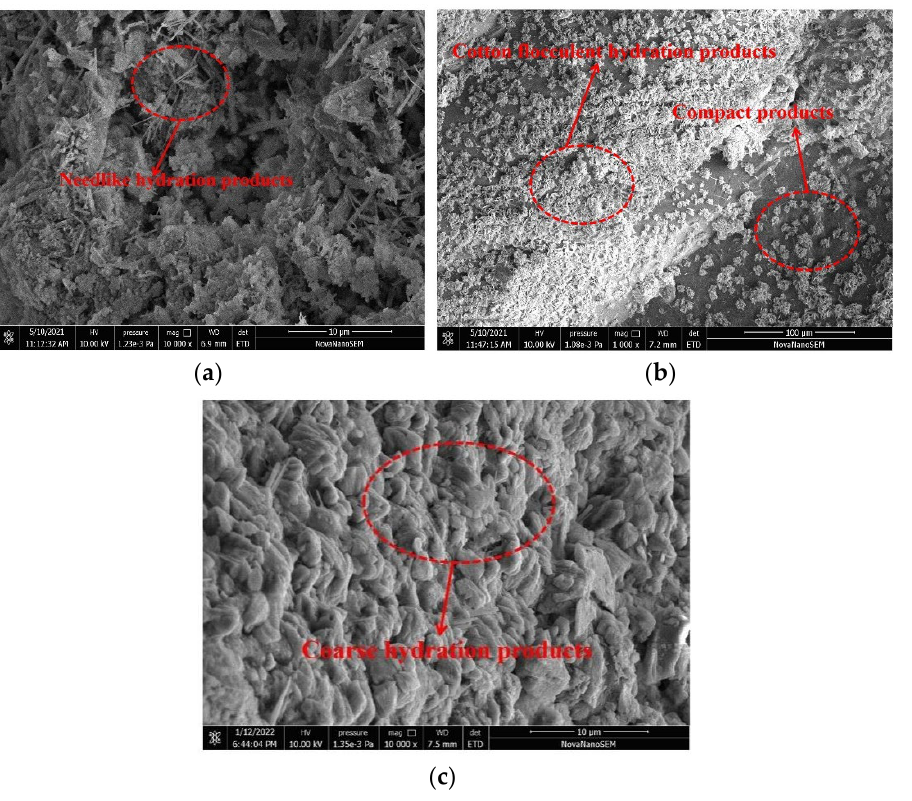
Figure 13. SEM micro-structure photos of specimens. ( a ) Standard cured alkali-activated FA. ( b ) Standard cured alkali-activated BFS. ( c ) CO 2 -cured alkali-activated BFS.